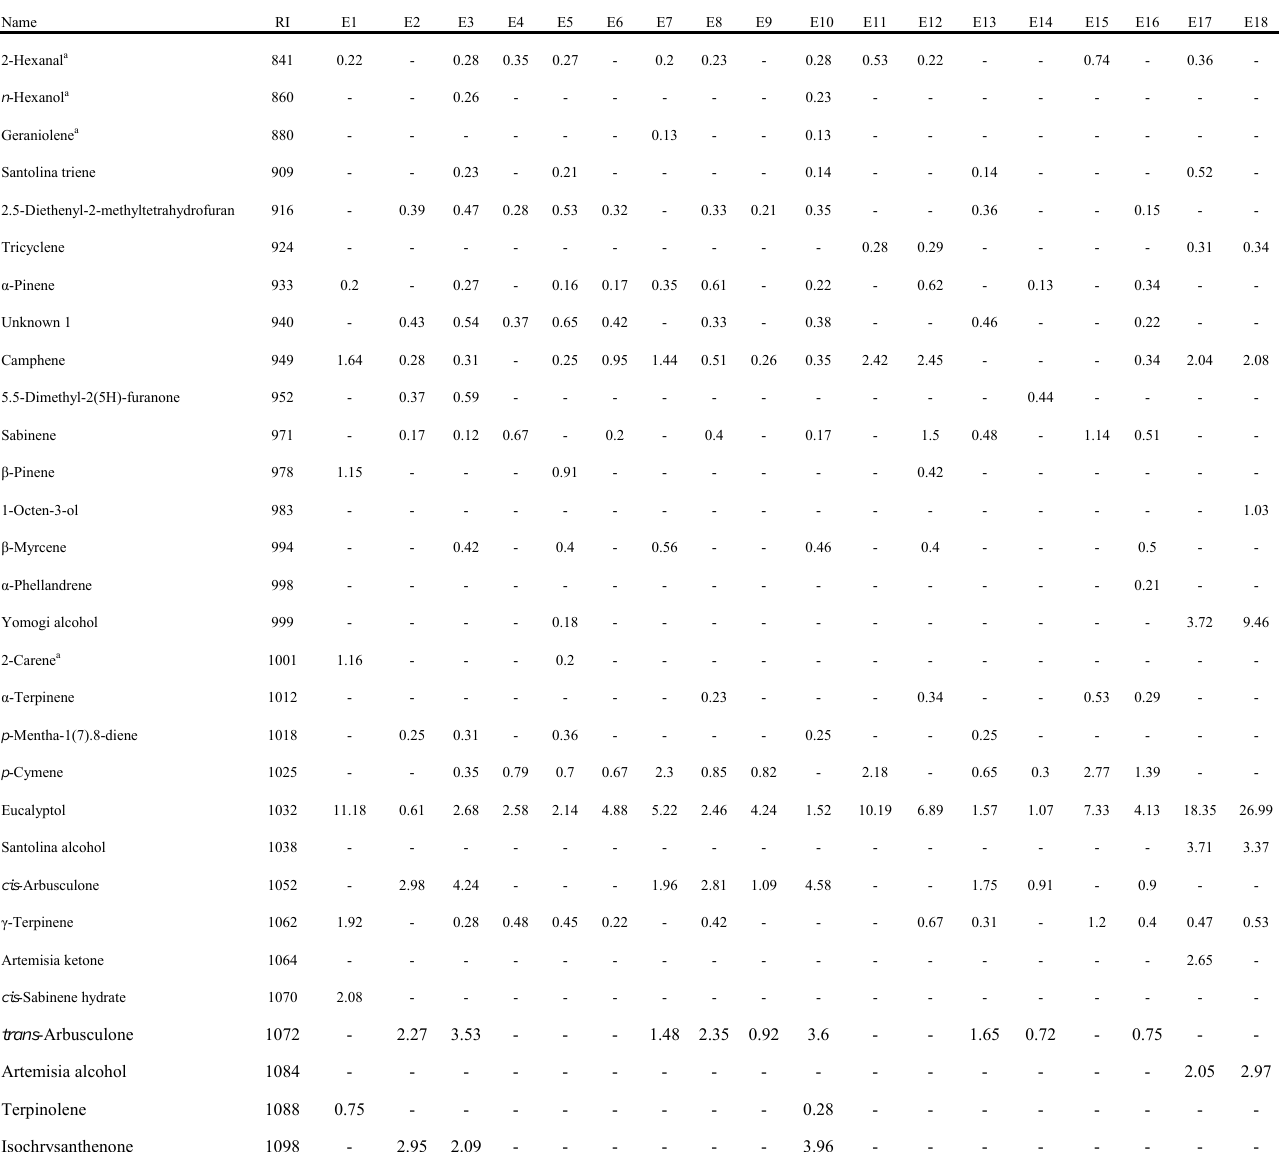
Table 1. Chemical composition of essential oils of Artemisia herba-alba